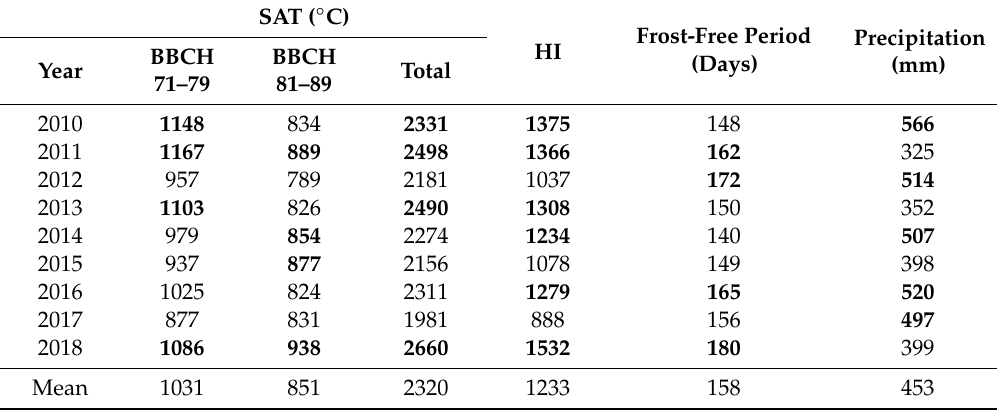
Table 3. The sum of active temperatures, Heliothermal Index, frost-free period, and the precipitation (April–October, 2010–2018). SAT ( ◦